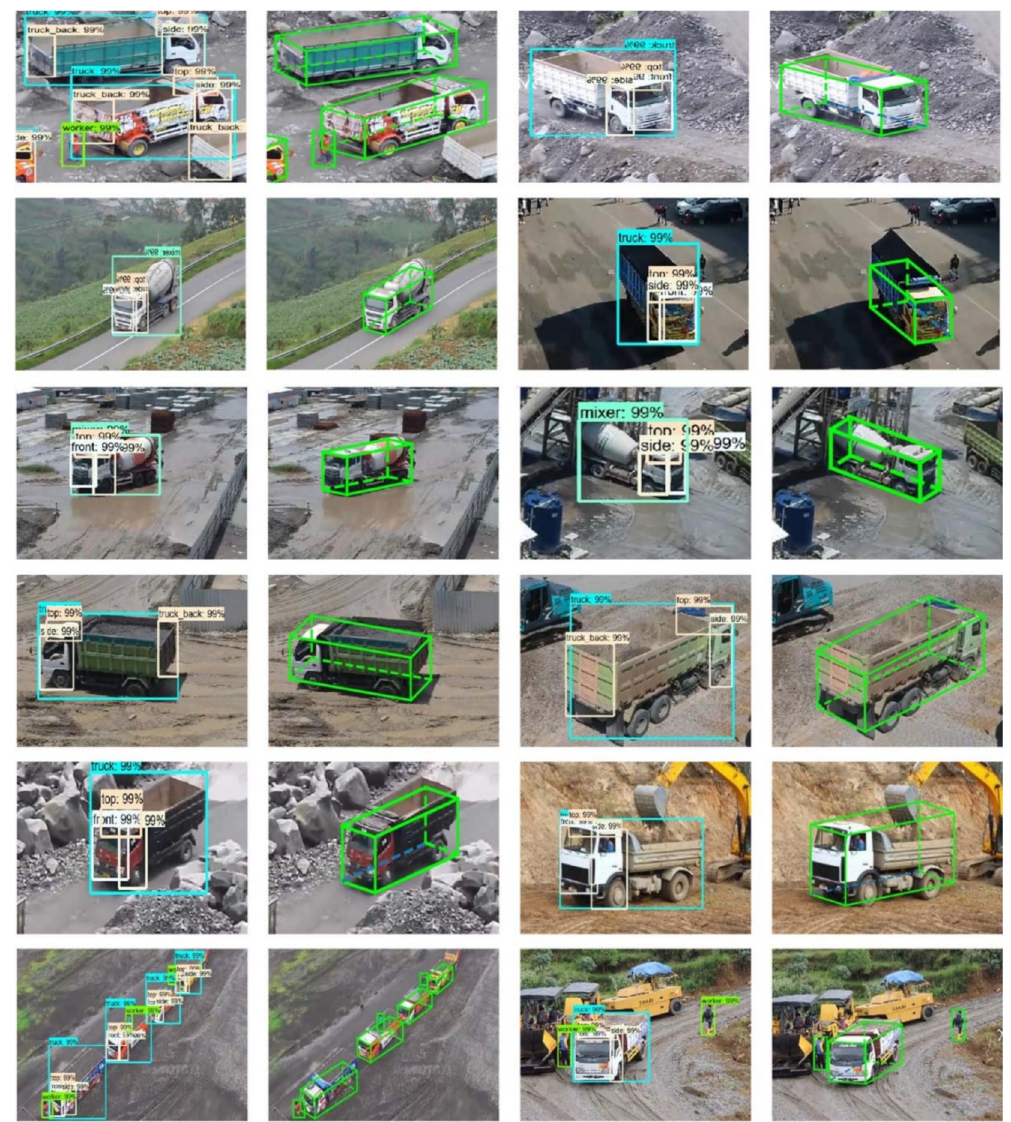
Figure 7. 3D Heavy vehicles in 3D relationship recognition